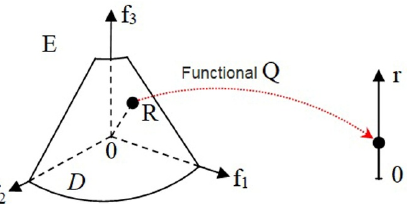
Figure 4. The Q function determines the distance between point R of a convex area, D, and the origin of coordinates of the normalized optimization criteria or the vector length, OR, in a non-negative multiobjective space, E.